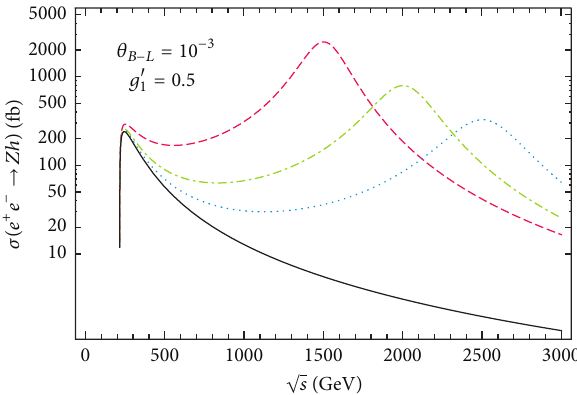
Figure 9: The same as Figure 8 but for 𝑔 󸀠 1 = 0 .